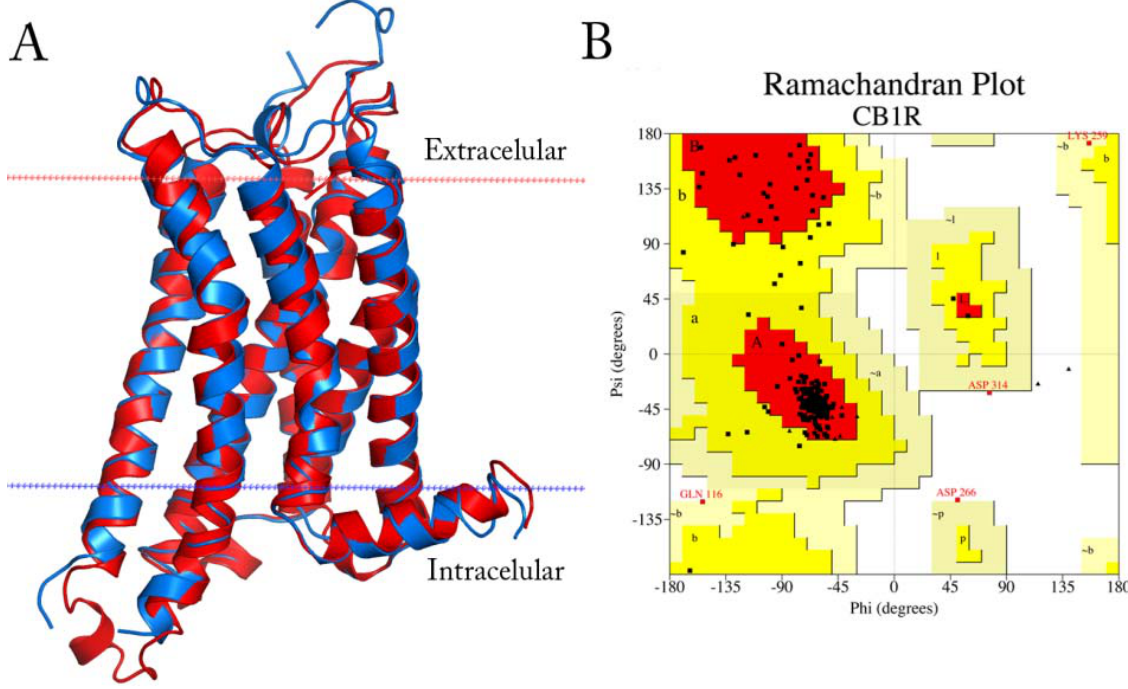
Figure 9. ( A ) Superimposition of the obtained CB1R model (red) with the A (blue). The plasma membrane is delimited by the red and blue dotted lines ( B ) Ramachandran plot for the CB1R